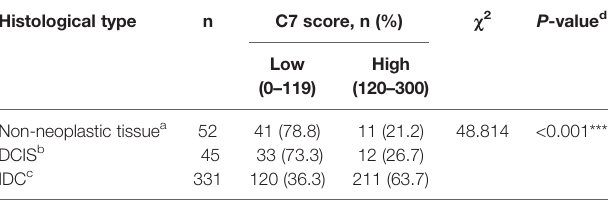
TABLE 1 | C7 expression in different breast tissue specimens.